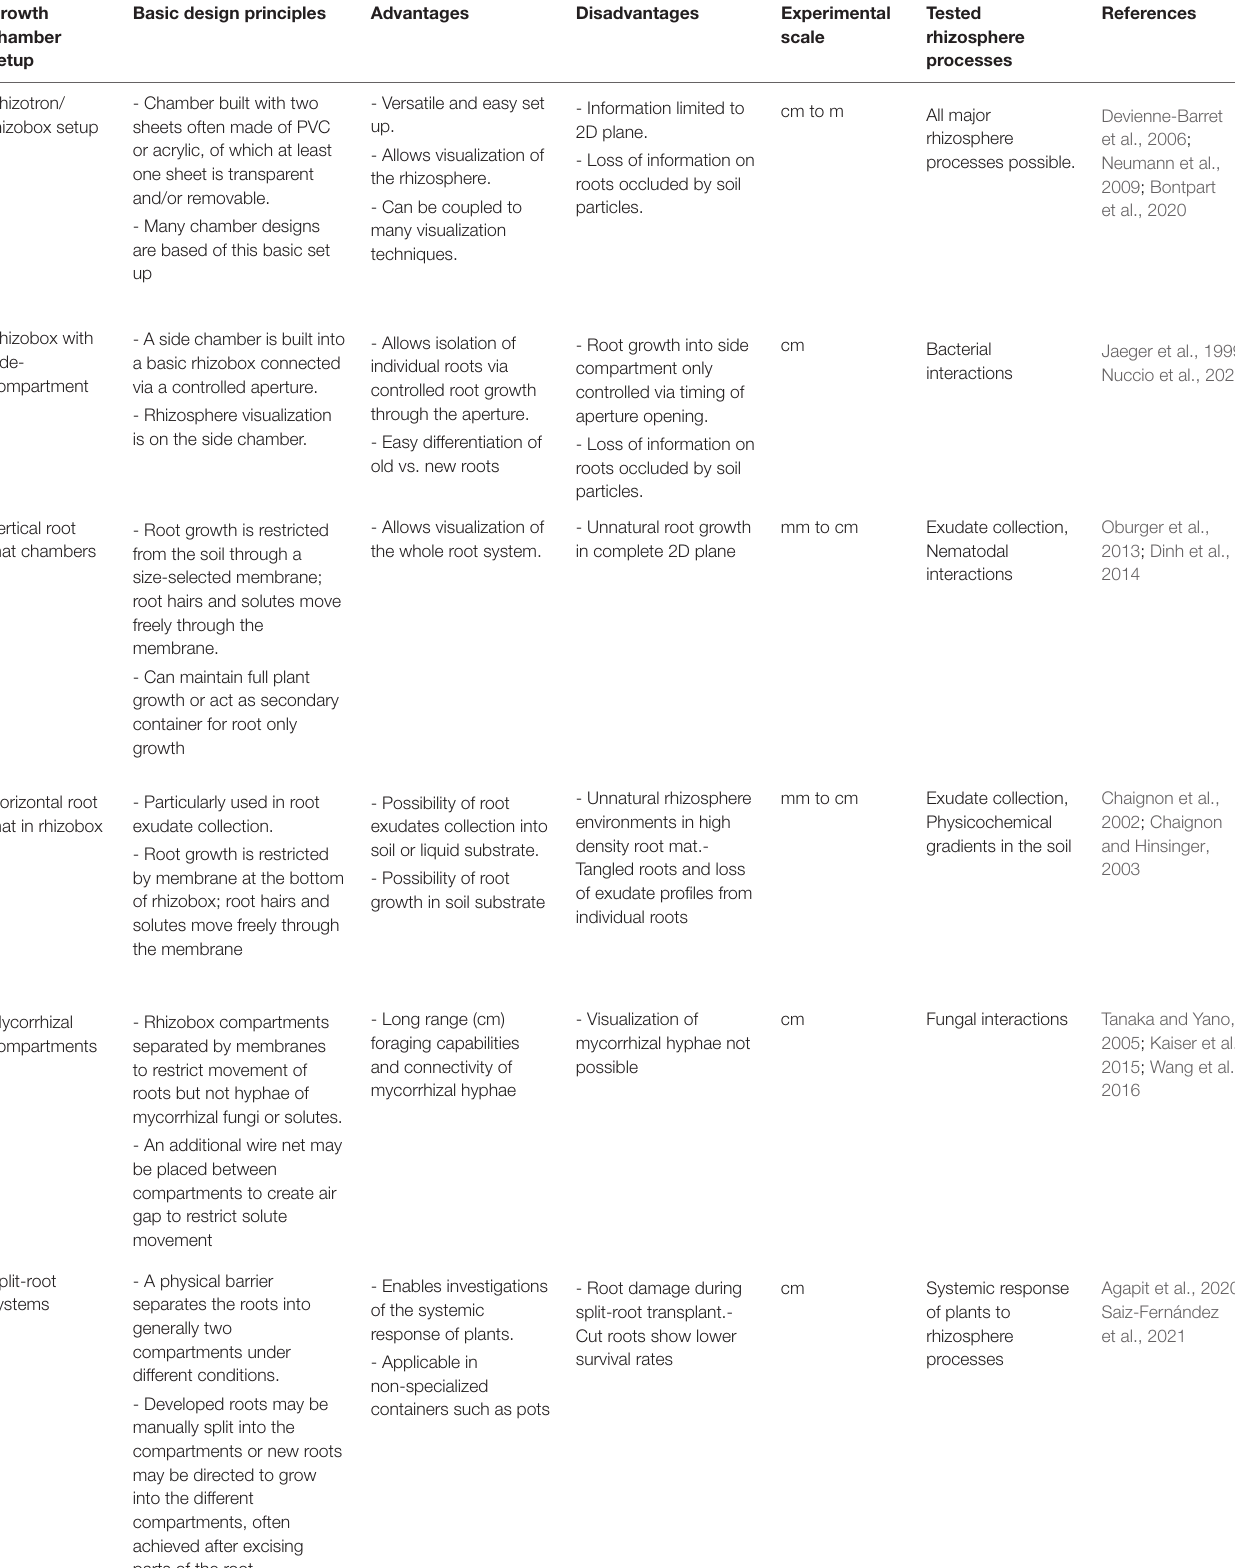
TABLE 1 | Key attributes of different growth chambers designed to study rhizosphere processes and